Question: How would you classify this visualization?
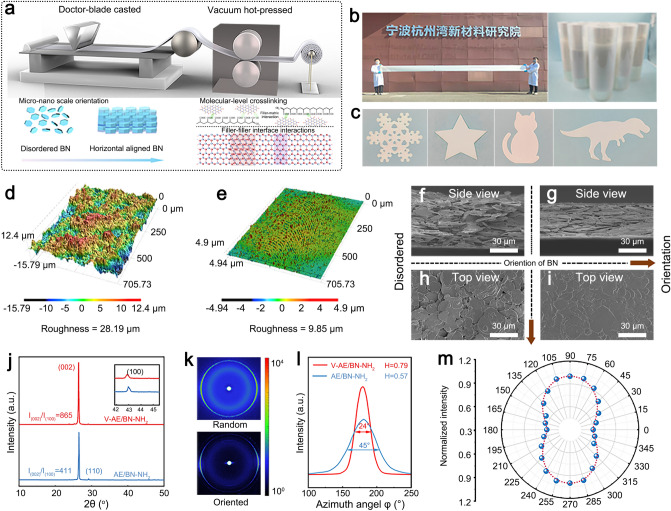
Answer: line